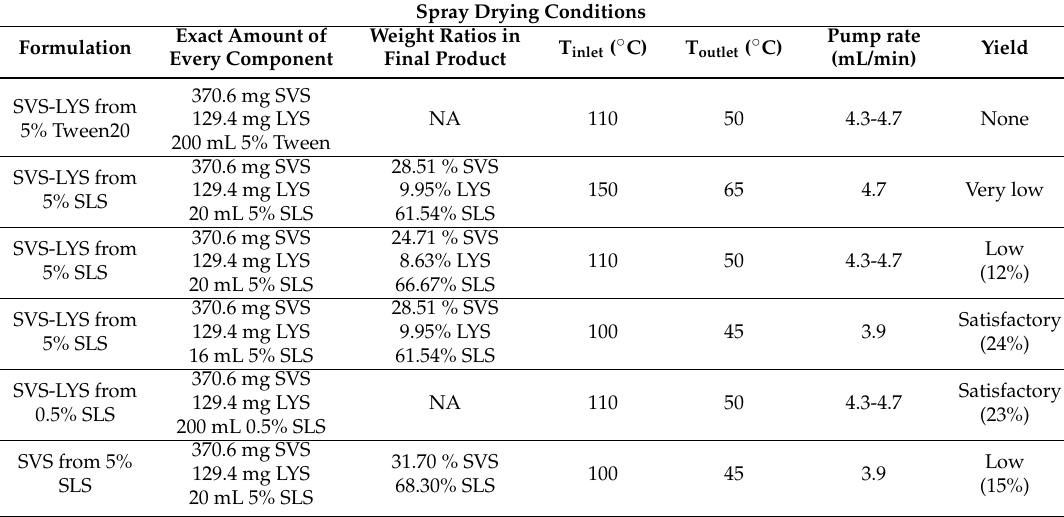
Table 2. Summary of the prepared formulations: exact amounts of the components, weight ratios in the final product, spray drying conditions used (T inlet , T outlet ( ˝ C), pump setting (%)), and the obtained